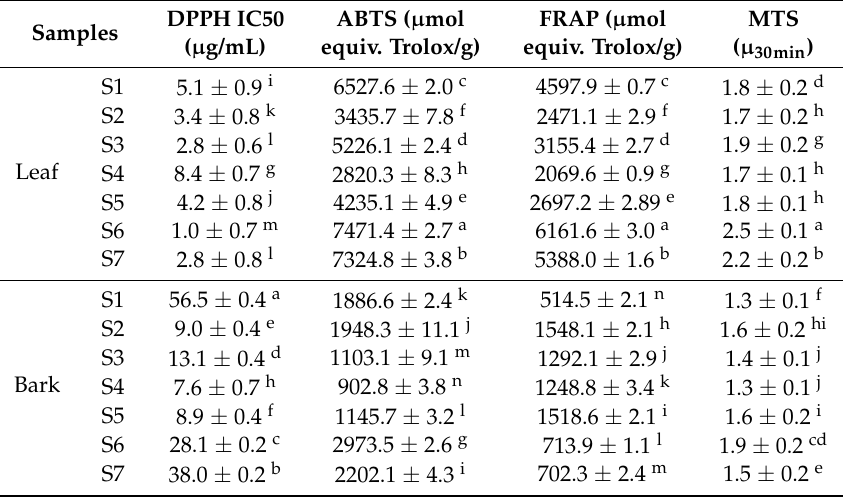
Table 4. Antioxidant activities of leaf and bark of different E. ulmoides